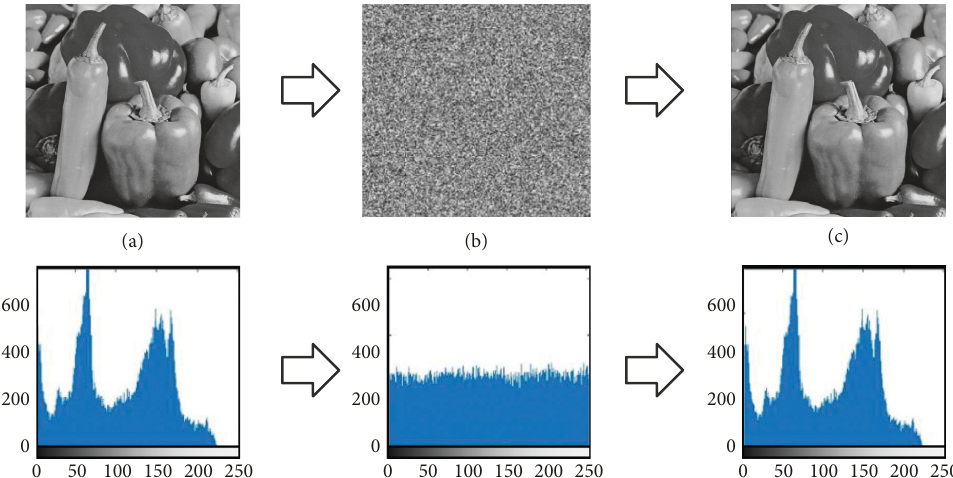
Figure 8: Histogram of plain and cipher image with the proposed method.